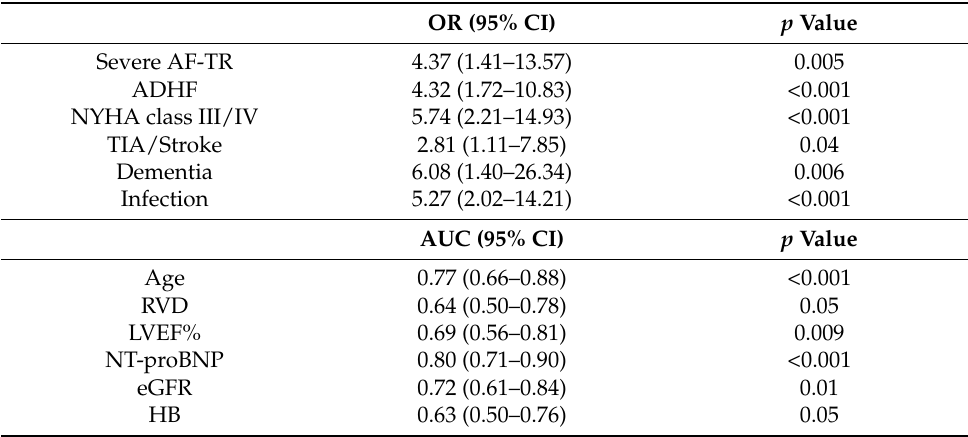
Table 5. Univariate analysis—predictors of mortality in AF patients.